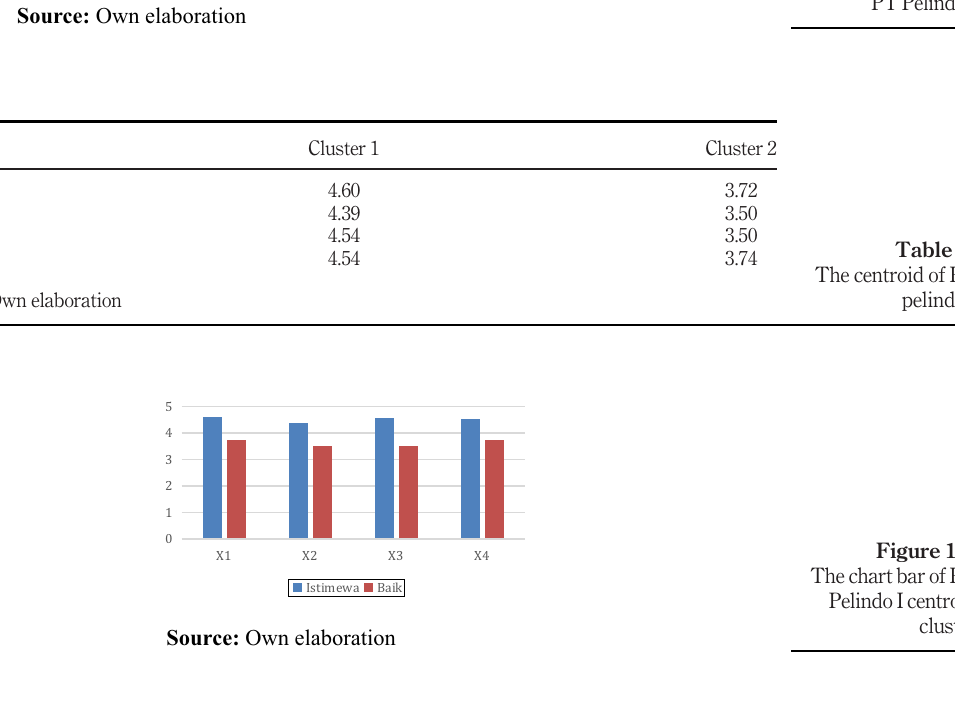
Figure 11. Scatter plot cluster of PT Pelindo I